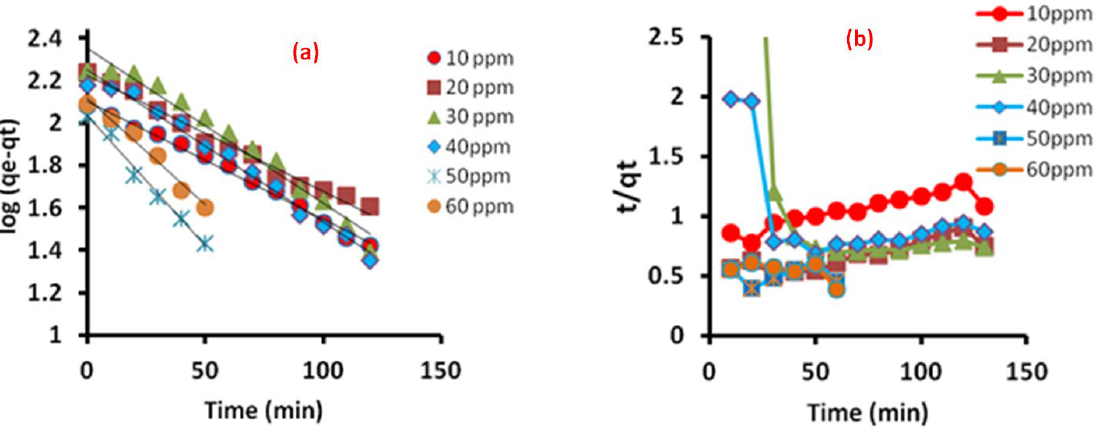
Figure 7. ( a ) Pseudo- first order and ( b ) pseudo-second order kinetic model for dye adsorption. Table 1. Comparison of pseudo first order and pseudo second order for the adsorption of MB dye on adsorbent at different initial concentrations of dye.